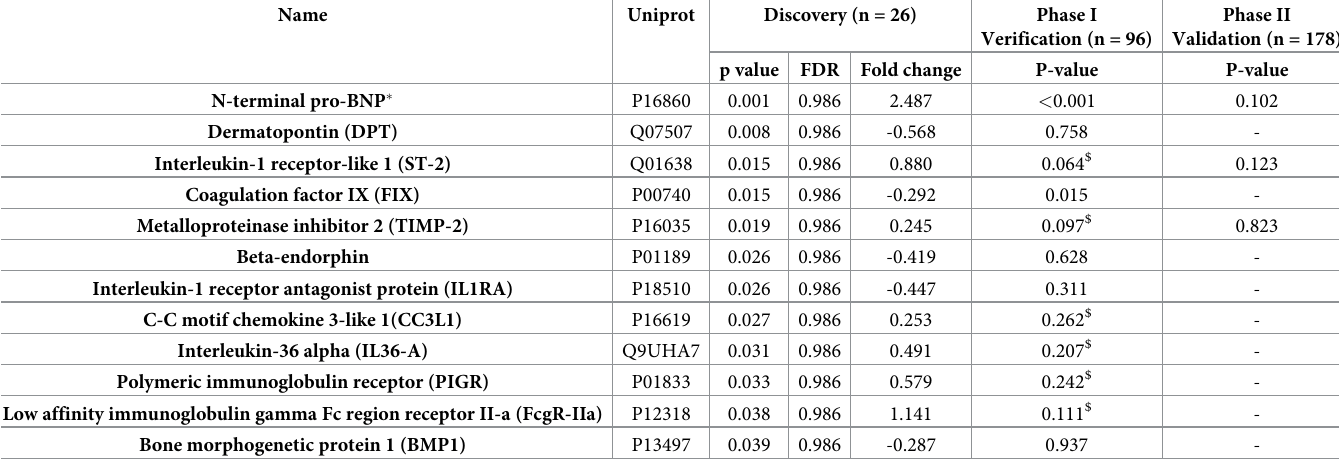
Table 2. Results from the comparisons of biomarker levels between AF and no AF in each phase of the biomarker